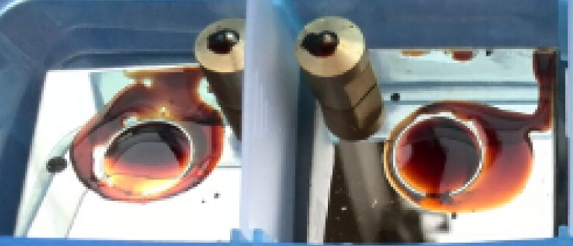
Figure 4. Photographic image of composite films after Pr irradiation and friction